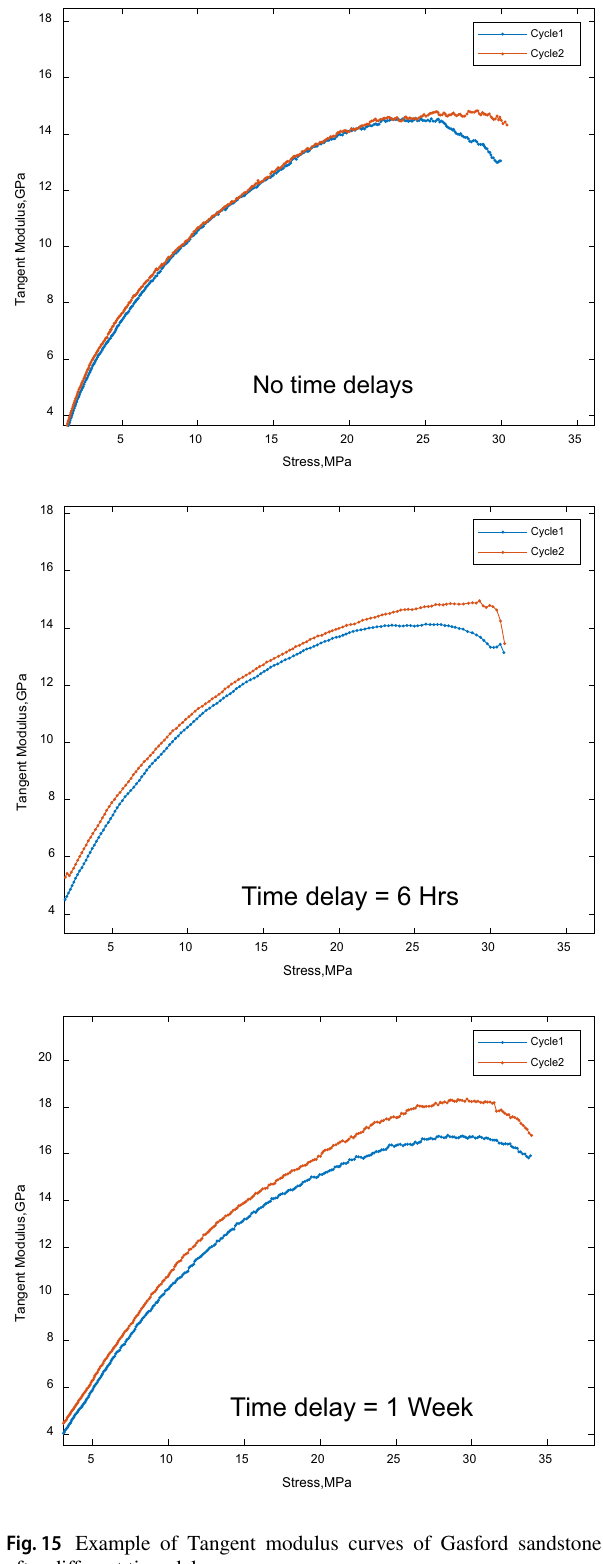
Fig. 15 Example of Tangent modulus curves of Gasford sandstone after different time